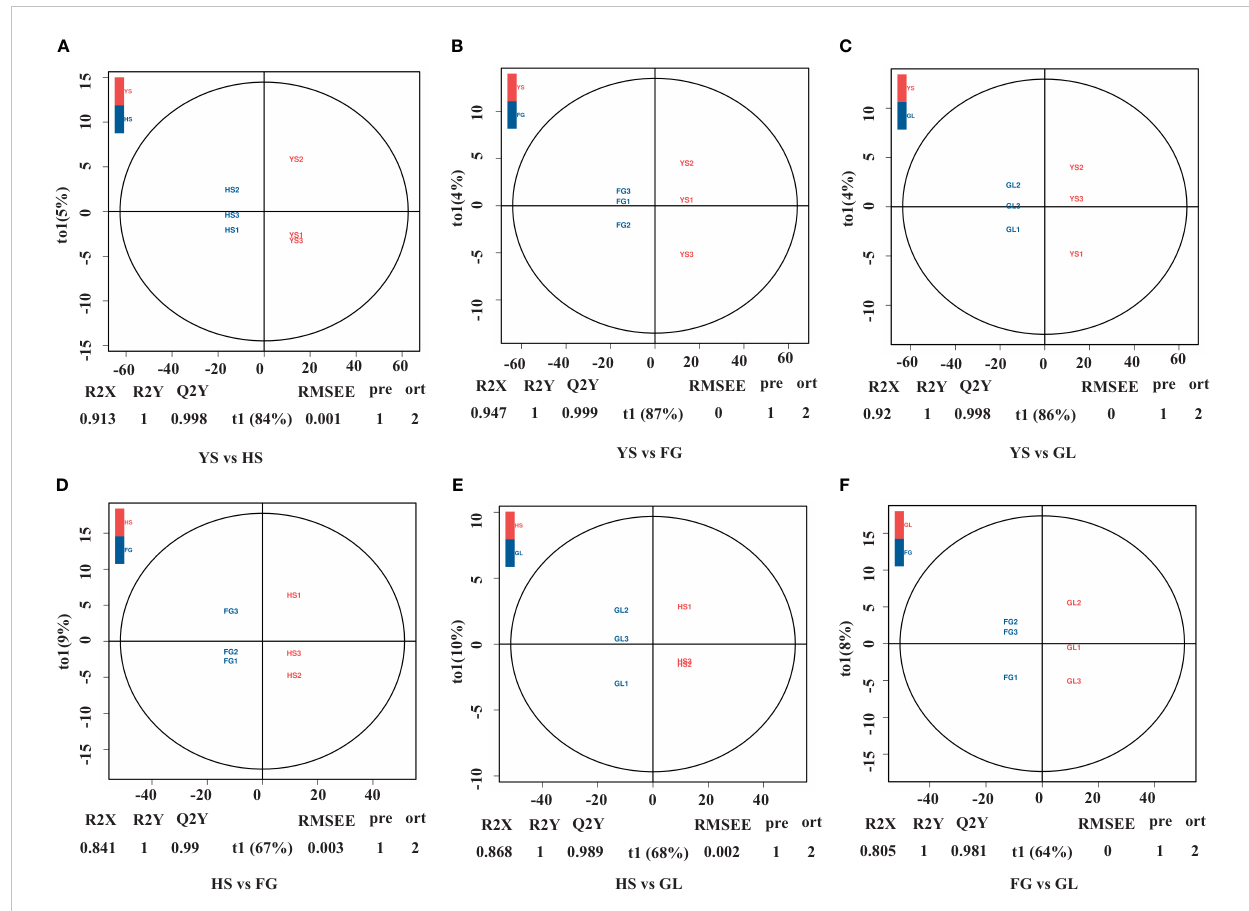
FIGURE 2 Differential fl avonoid accumulation analysis using orthogonal signal correction and orthogonal partial least squares-discriminant analysis. HS, FG, GL, P. thomsonii varieties; YS, P. lobata variety. Pairwise comparisons YS vs. HS (A) , YS vs. FG (B) , YS vs. GL (C) , HS vs. FG (D) , HS vs. GL (E) , and FG vs. GL (F)